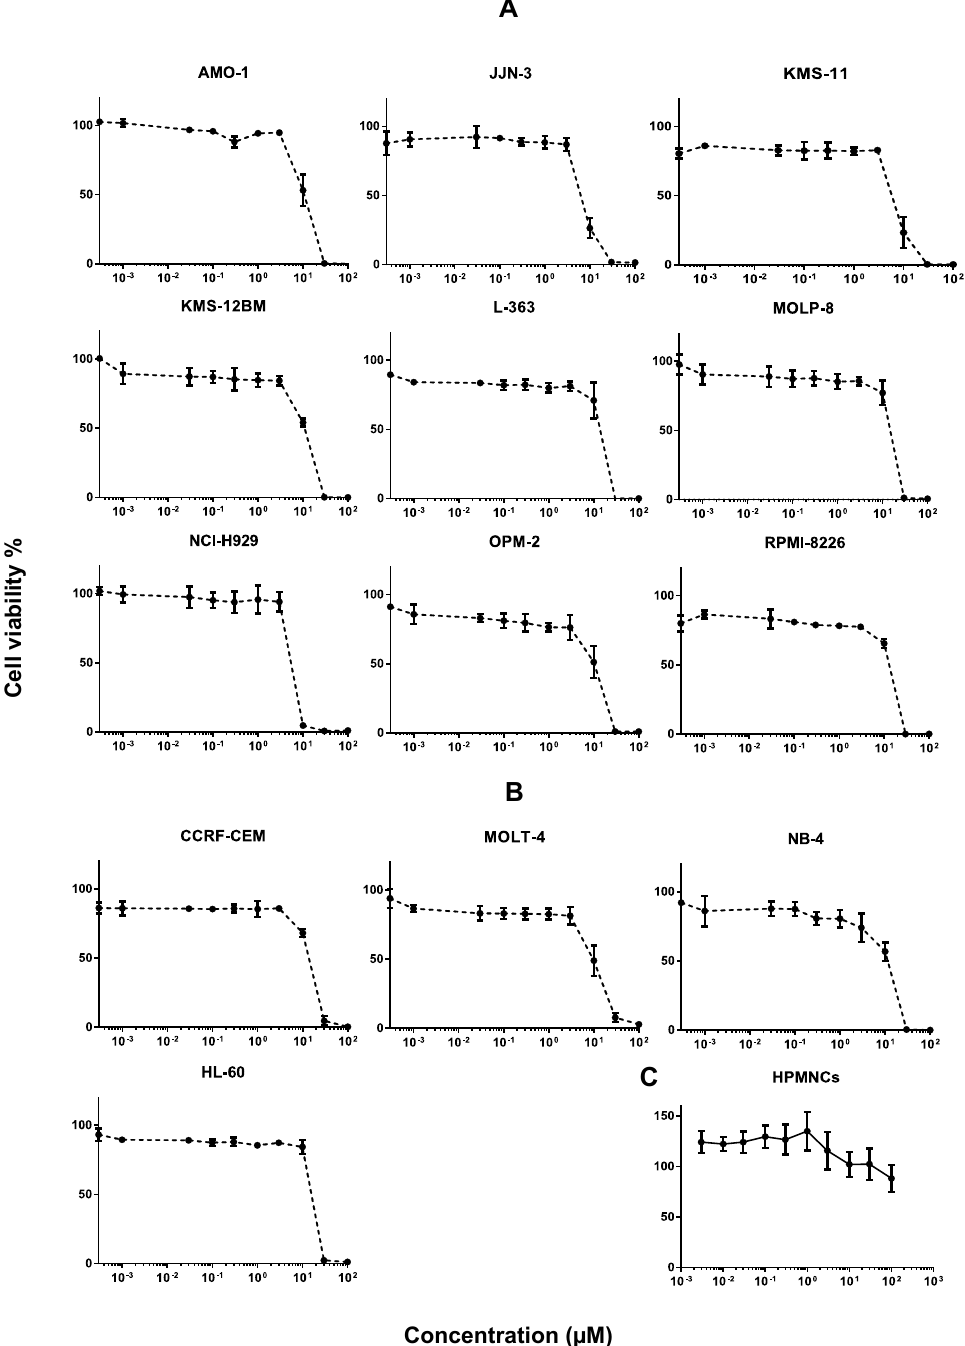
Figure 2. Dose-response curves of secalonic acid F (SAF). ( A ) Cytotoxicity of SAF toward various multiple myeloma cells as determined by the resazurin assay. ( B ) Cytotoxicity of SAF toward various leukemia cells as determined by the resazurin assay. ( C ) Toxicity of SAF toward human peripheral mononuclear cells (HPMNCs) as determined by the resazurin assay.